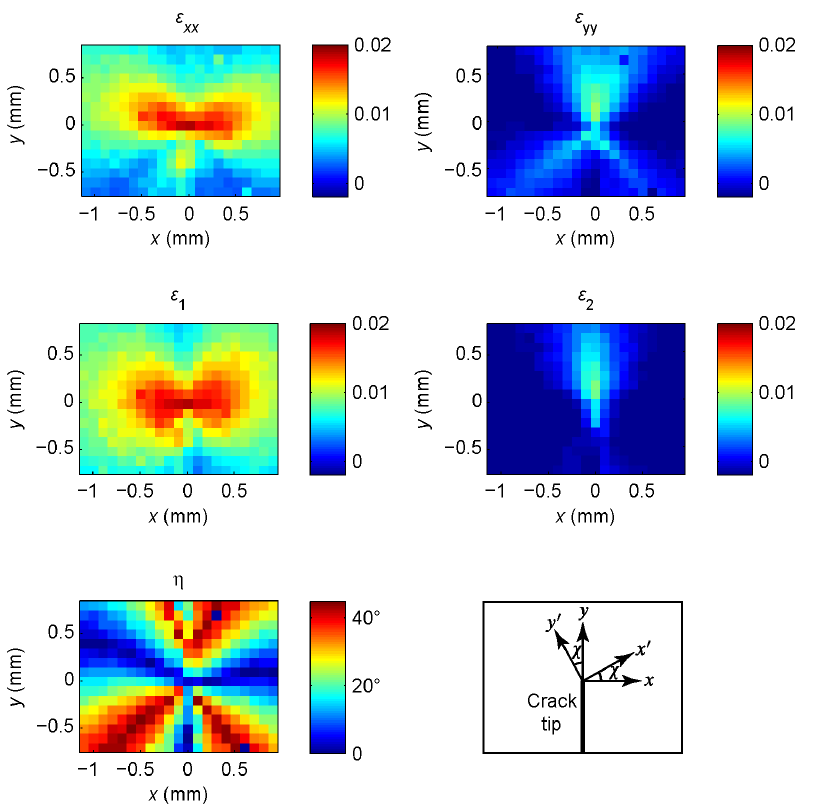
Figure 3. Strain maps around the crack tip of an amorphous Zr 57 Ti 5 Cu 20 Ni 8 Al 10 specimen loaded in the SENB geometry loaded to a stress intensity K ~ 76 MPam 1 = 2 at room temperature. Top row: Normal strains in the laboratory coordinate system, xx and E yy . Middle: Principal strains E 1 and E 2 , the orientation of which defines the x 0 {{ y 0 coordinate system. Bottom: Orientation of principal axes with respect to the lab coordinate system, x . See also Fig. 9.